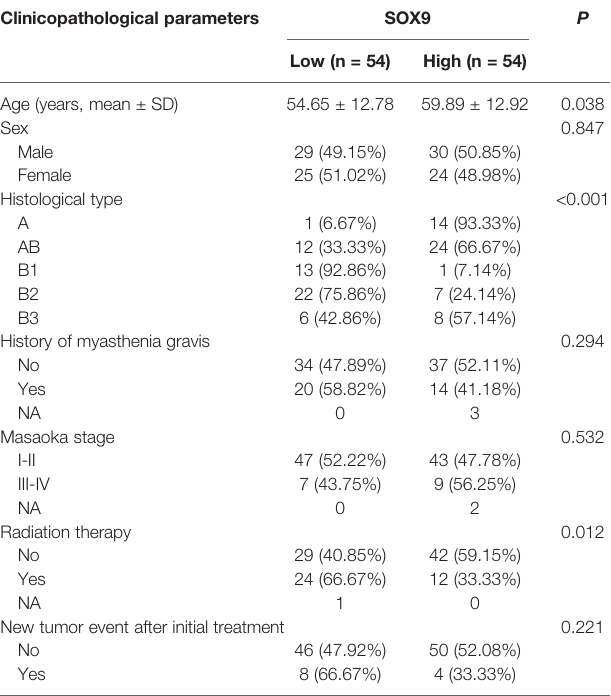
TABLE 2 | Correlation between SOX9 RNA expression and clinicopathological parameters of patients with thymomas in the TCGA cohort. Clinicopathological parameters